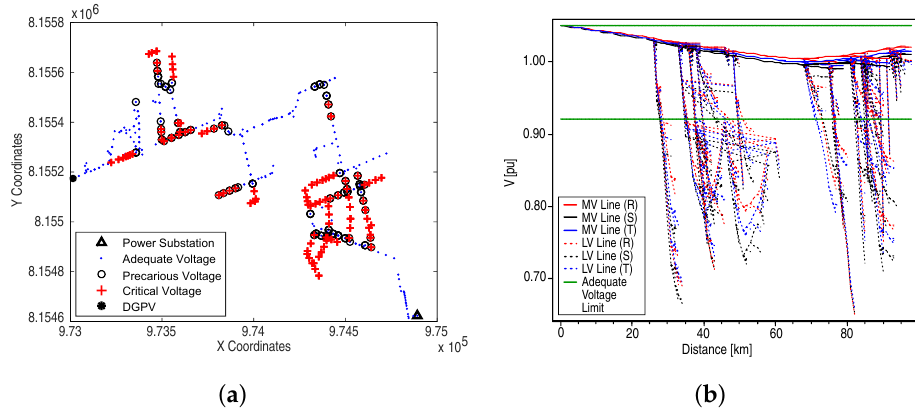
Figure 19. Analysis 1: ( a ) voltage rating and ( b ) voltage profile.